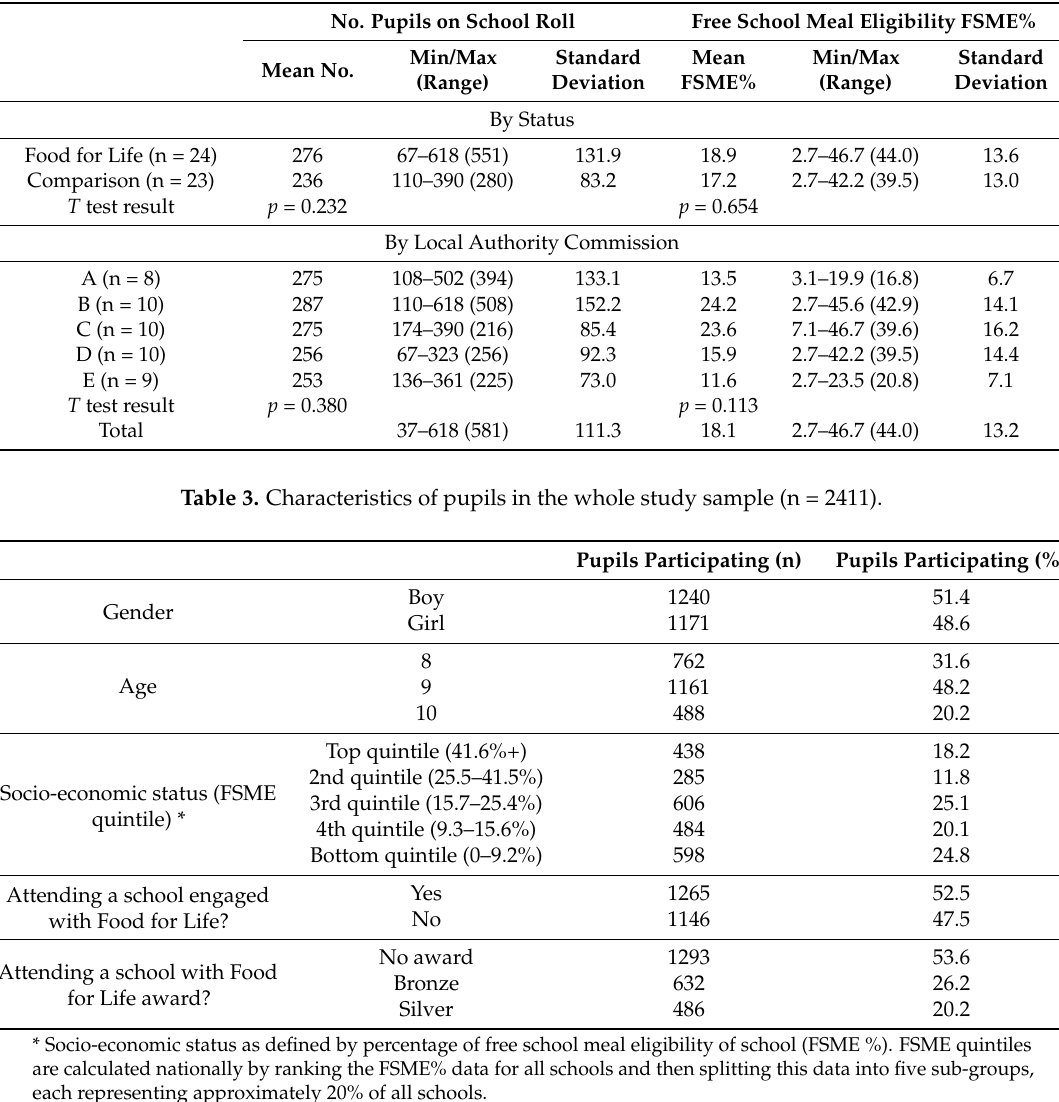
Table 2. Characteristics of school sizes (pupil roll) and school level Free School Meal Eligibility (FSME).